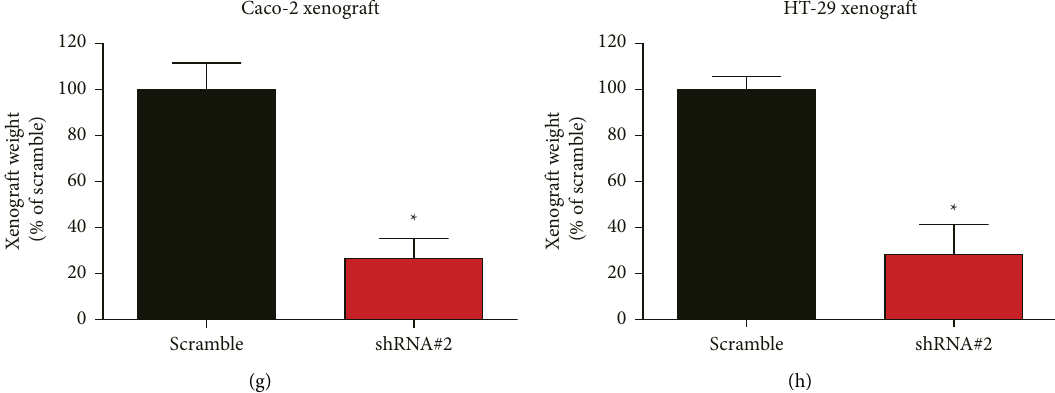
Figure 4: CSRP1-knockdown attenuates COAD progression both in vitro and in vivo. (a), (b) Te shRNAs targeting CSRP1 and scrambled control shRNA were transfected into caco-2 and HT-29 cells, respectively. Te knockdown efciency was tested via western blot. (c), (d) CCK-8 assay was conducted to evaluate the proliferation curve of transfected cells. (e), (f) Transwell assay was conducted to assess the migration capacity of transfected cells. (g), (h) Te xenografts originated from diferent transfected cell lines were weighted and compared after culturing for one